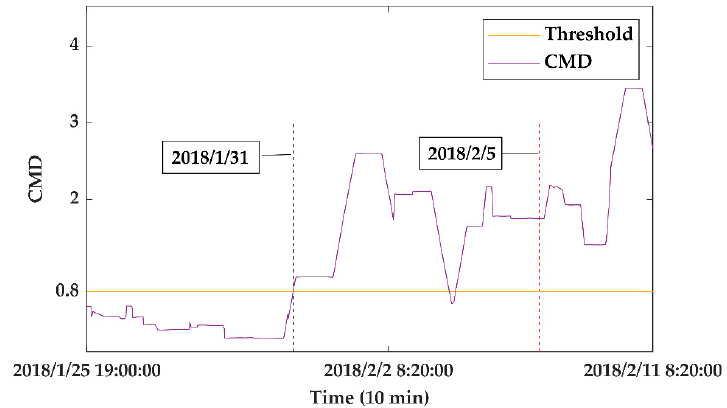
Appl. Sci. 2021 , 11 , x FOR PEER REVIEW Figure 9. The changing curve of the CMD for hydropower units in case 2. Figure 9. The changing curve of the CMD for hydropower units in case 2.